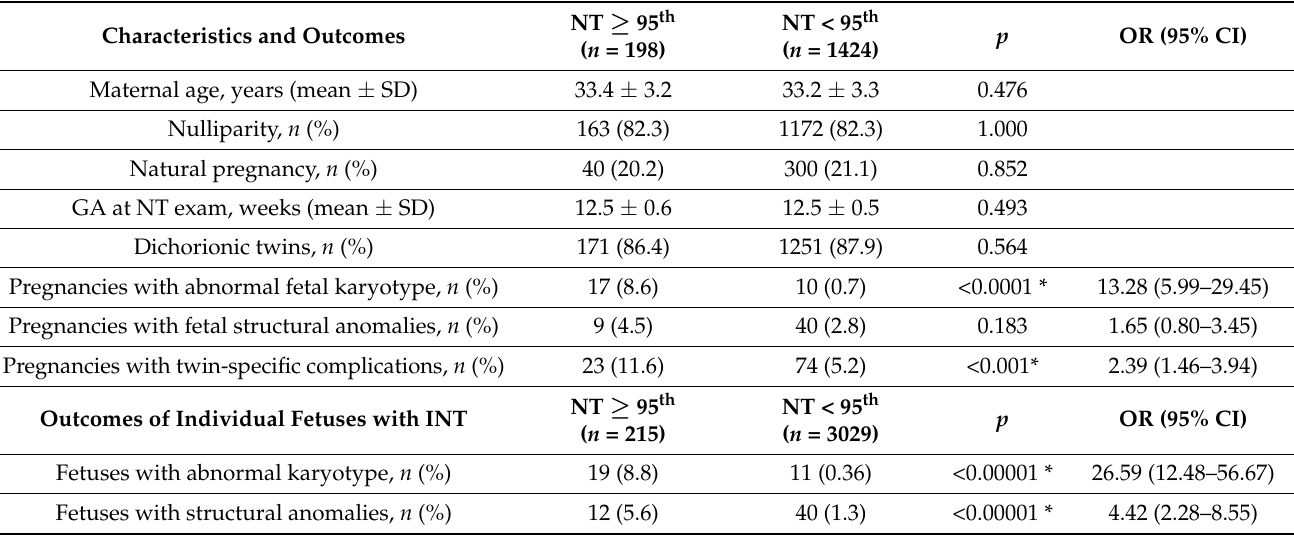
Table 2. Comparison of Demographic characteristics and pregnancy outcomes in all twin pregnancies and individual fetuses between increased NT ≥ 95 th and normal